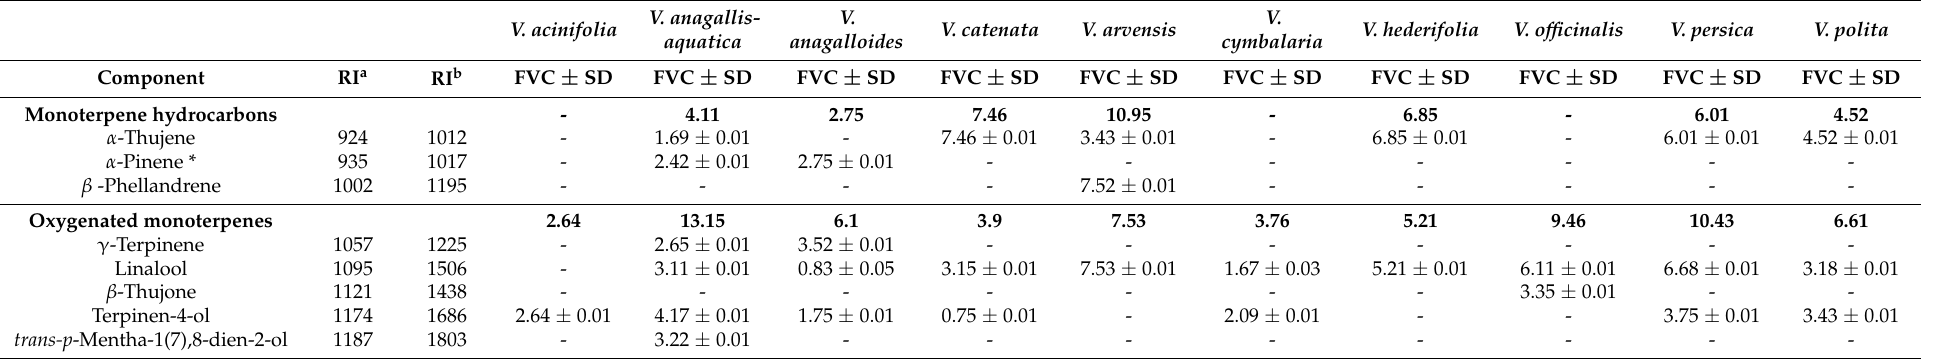
Table 2. Free volatile compounds (FVCs) of the hydrosols obtained by microwave extraction from the aerial parts of Veronica